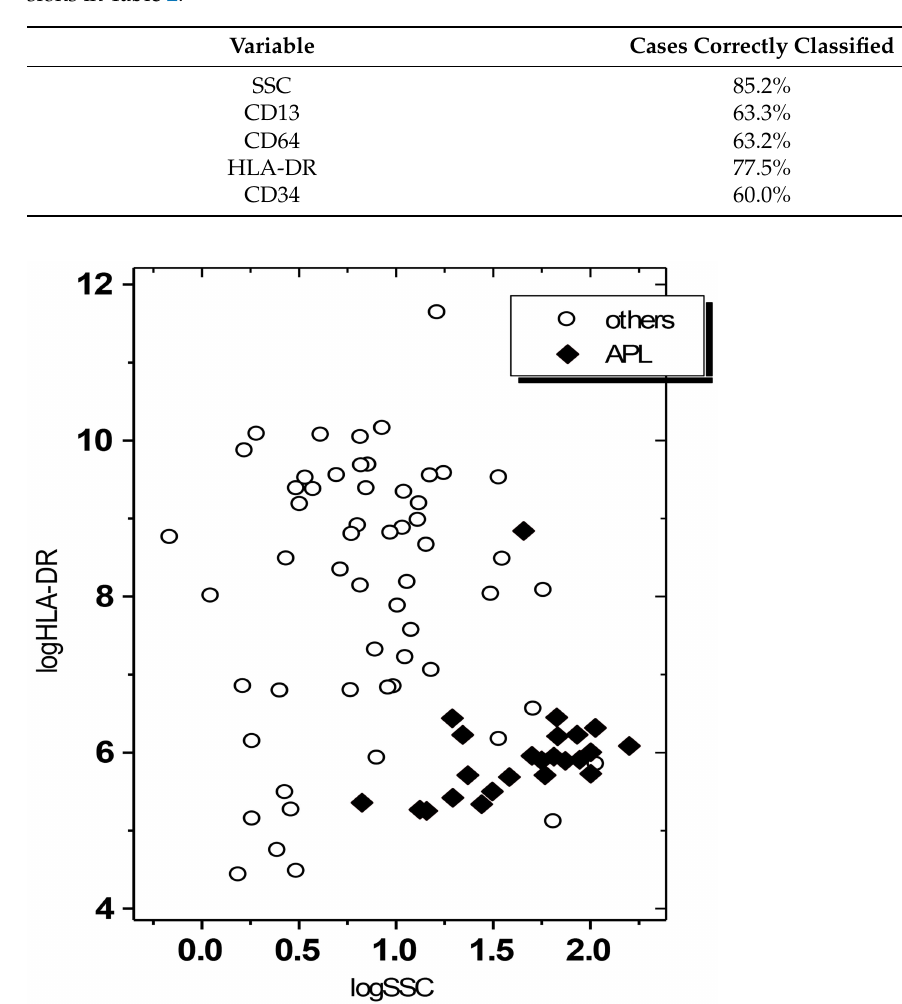
Table 3. Univariate discriminant analyses for the antigens that showed significantly different expres- sions in Table 2.